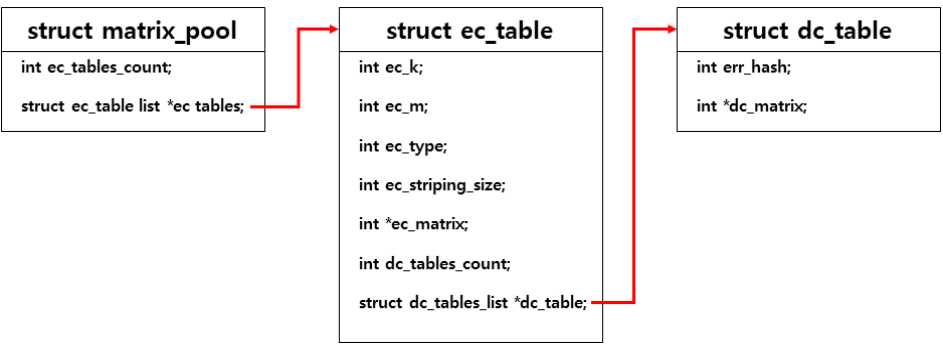
Figure 18. Data structure to compose the matrix.